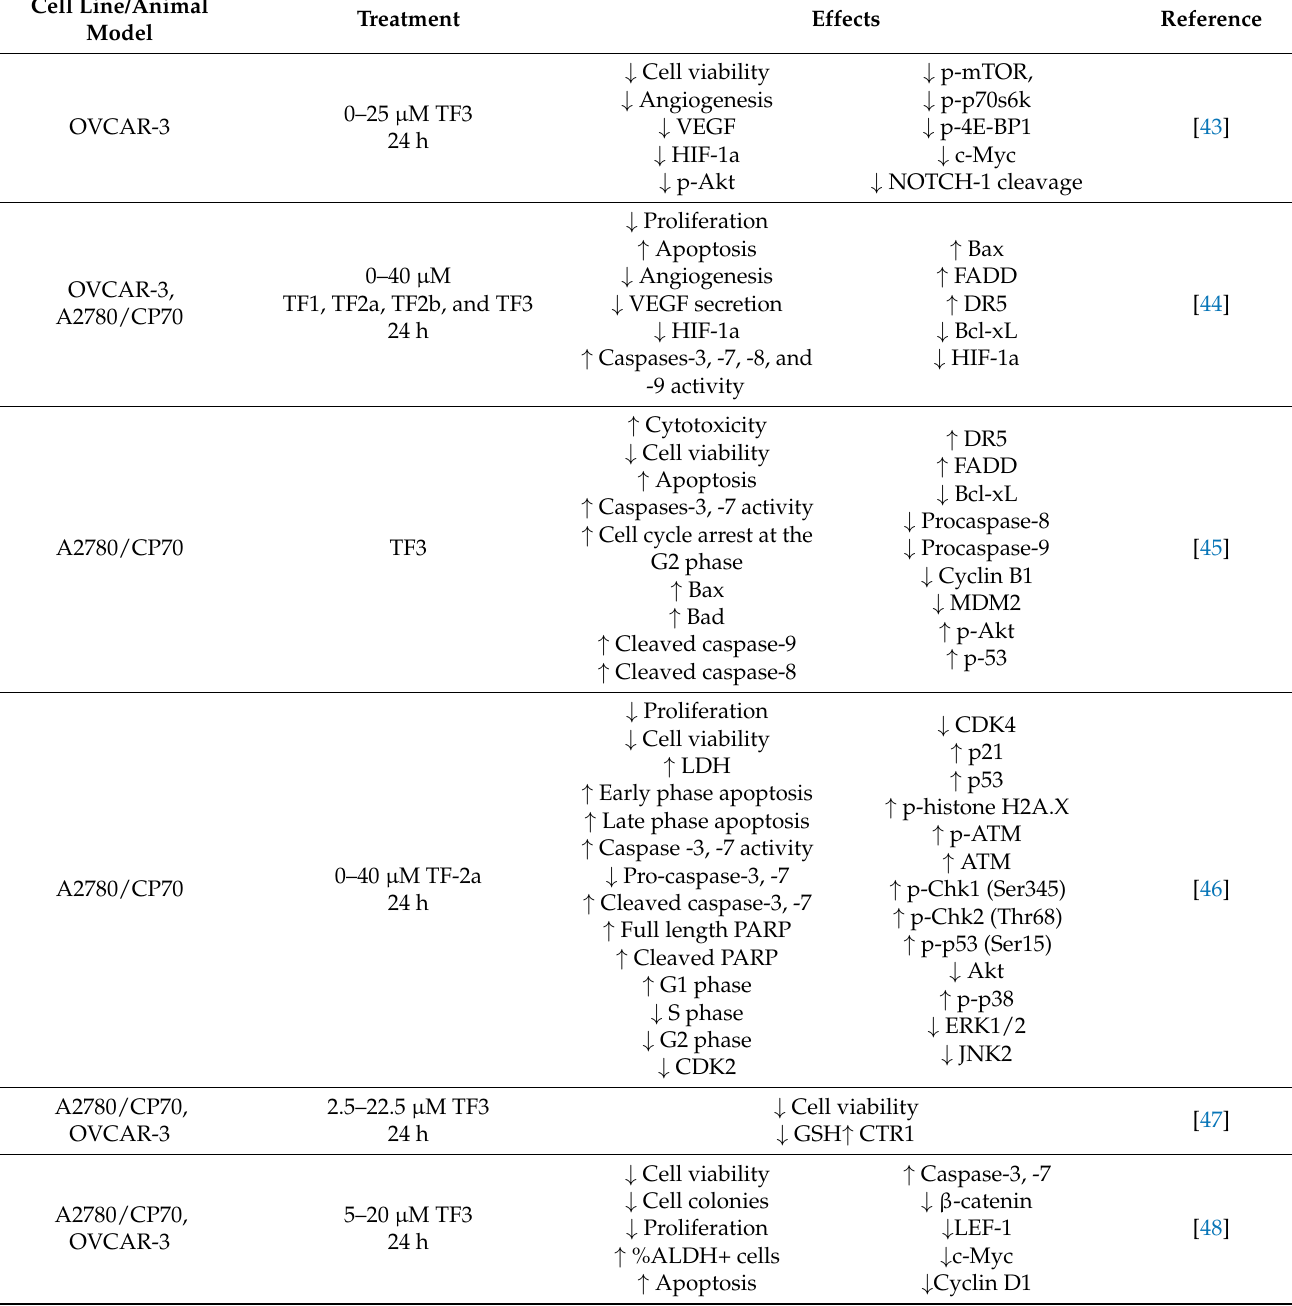
Table 5. Effects of theaflavins in ovarian